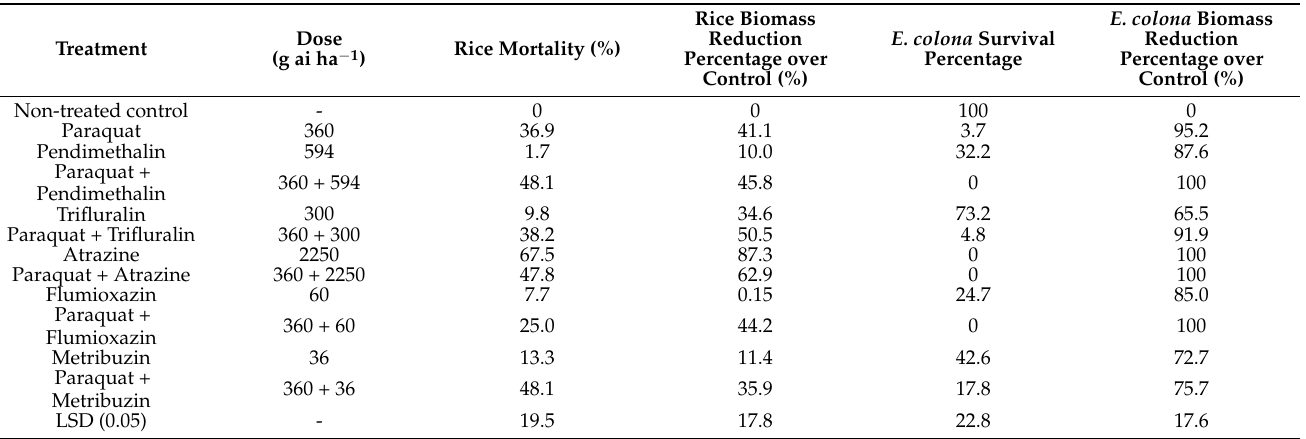
Table 7. Efficacy of paraquat alone and its tank-mixed application with other pre-emergent herbicides against Echinochloa colona and